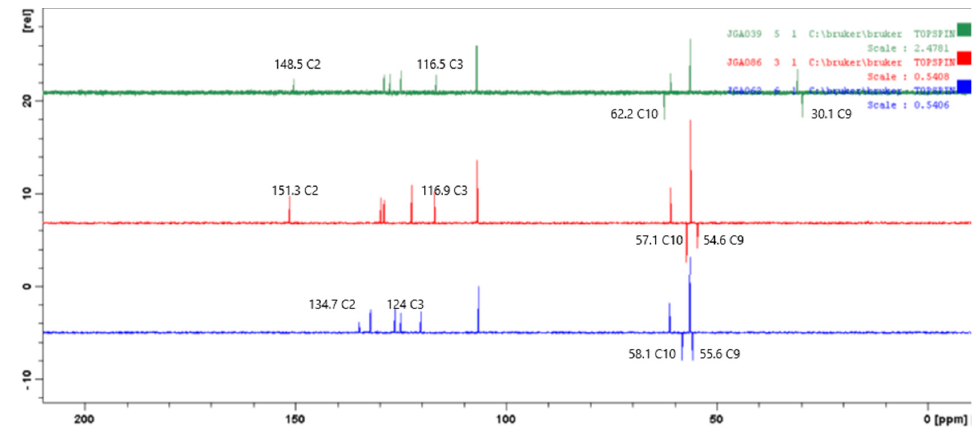
Figure 4. DEPT-135o spectra of compounds 14 , 46 , 67 .